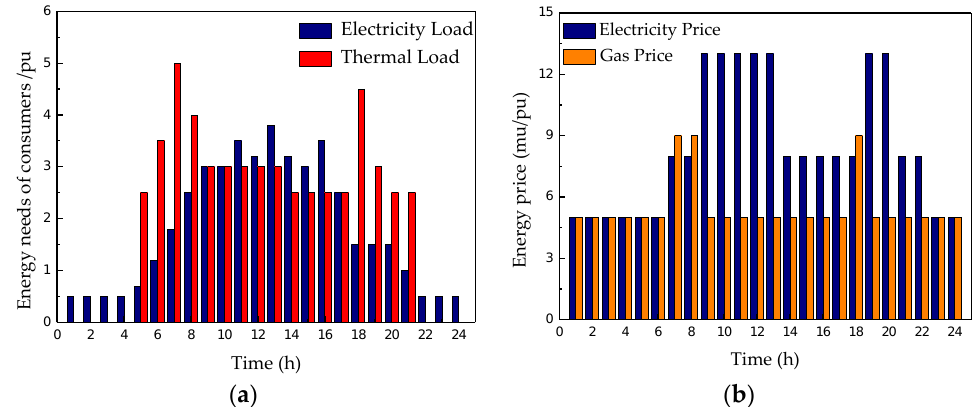
Figure 8. Energy needs and energy pricing: ( a ) Electricity loads and thermal loads; ( b ) time of use (TOU) pricing in MECS.